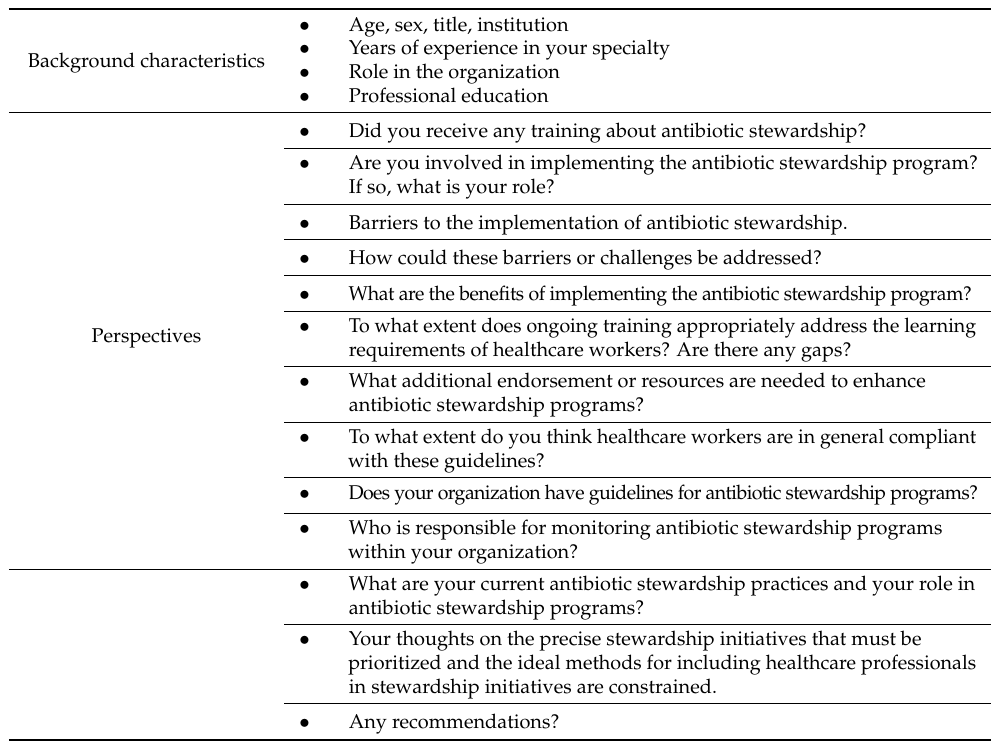
Table 1. Interview